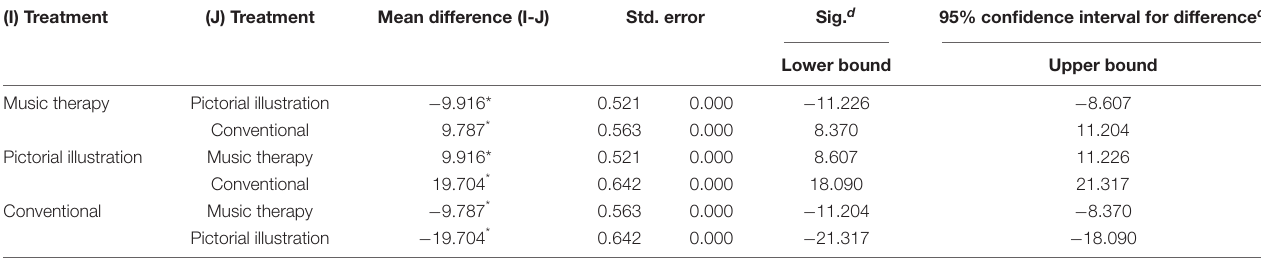
TABLE 3 | Bonferroni post hoc analysis of the reading performance by